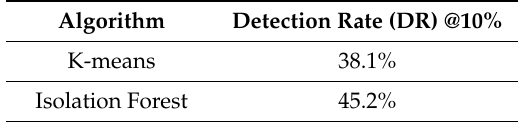
Table 5. Detection rate of di ff erent algorithms on the SMOTE 10 k